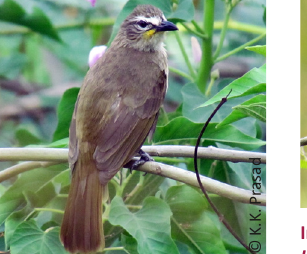
Image 61. Common Tailor Bird Orthotomus sutorius